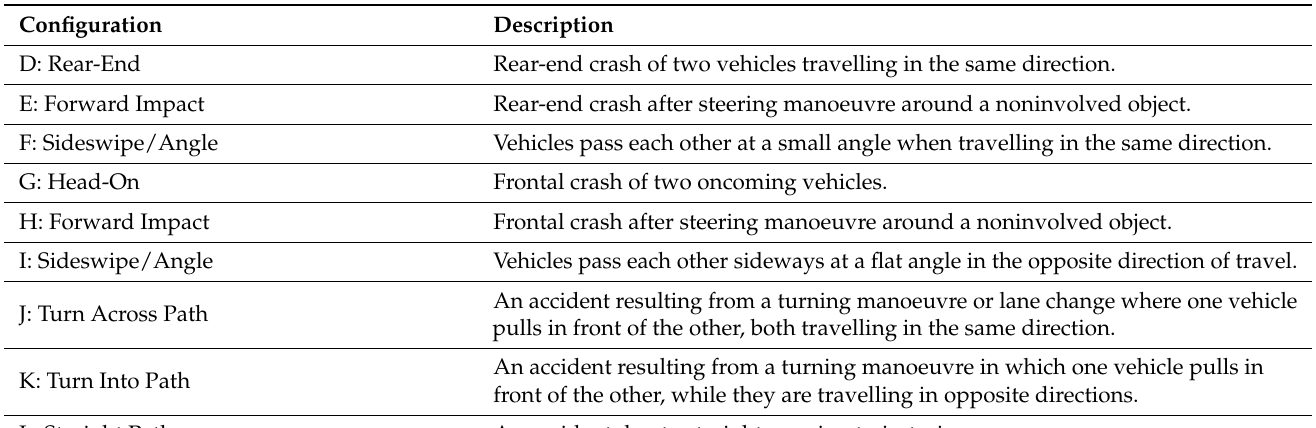
Table 2. Description of the crash configurations within the CISS database according to [16]. Configuration